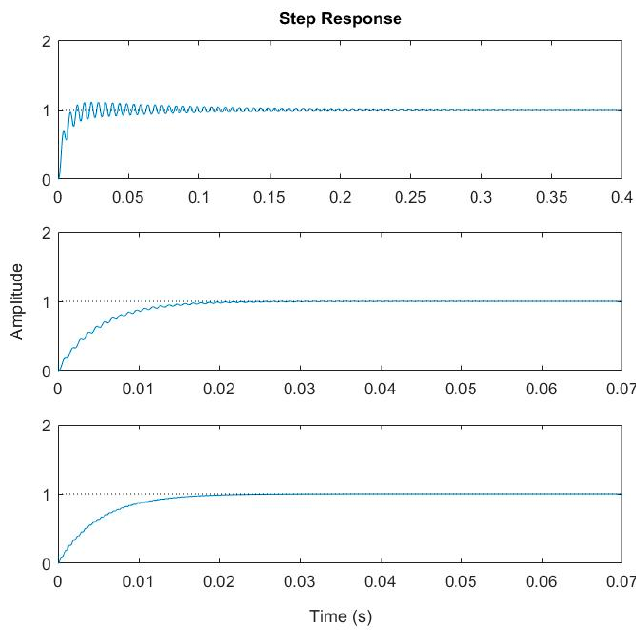
Figure 6. Step response with (cid:2028) = 5 ms and different resonant frequencies ( (cid:1858) (cid:2868) = 0.2, 1.0, 2.0 kHz).